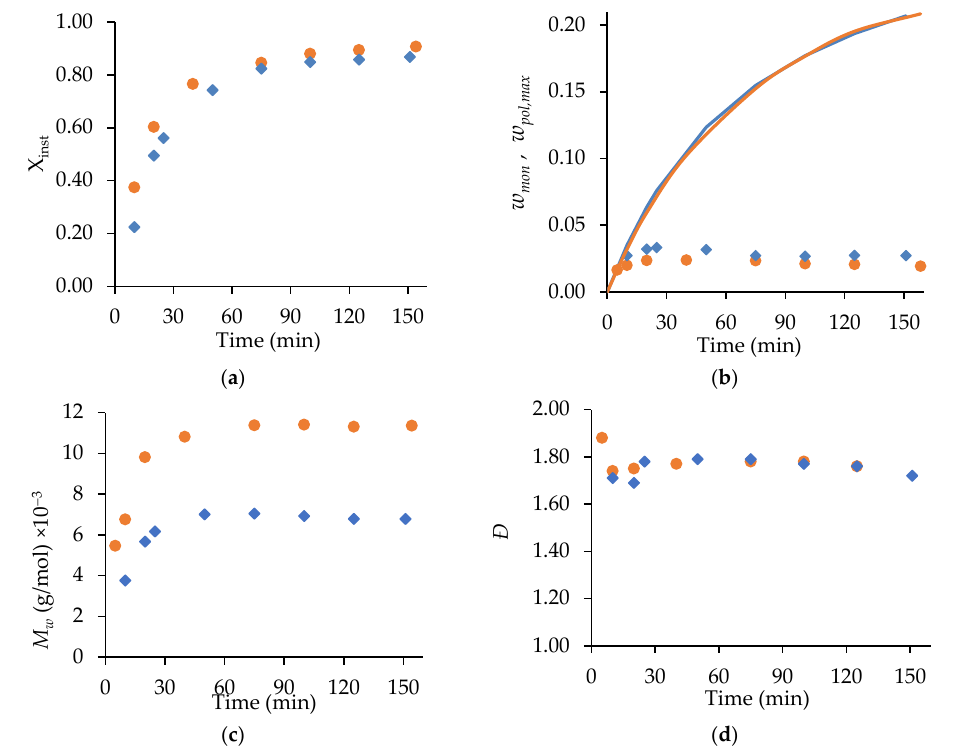
Figure 3. A comparison of MA ( (cid:117) ) and t-BuAAm ( • ) profiles from semi-batch homopolymerizations run under identical conditions with a final monomer/polymer content of 20 wt% in 75/25 EtOH/H 2 O with 2 wt% AIBN at 70 ℃ : ( a ) instantaneous conversion ( X inst ), ( b ) unreacted weight fraction monomer w mon (symbols) and maximum polymer content w pol,max (solid line), ( c ) M w , ( d ) Ð .